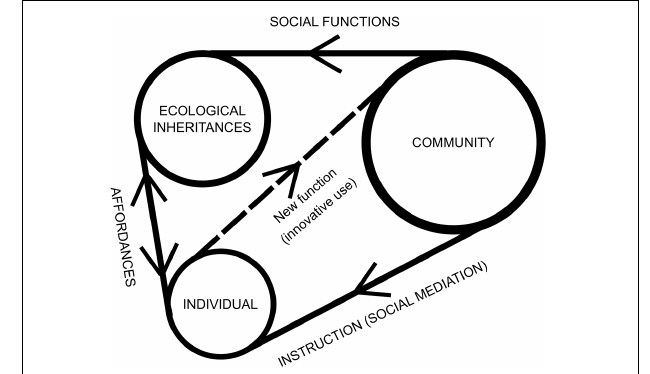
FIGURE 2 | Different interactions among an individual, her community and the ecological inheritances of her environment. Ecological inheritances are bestowed by the community with social functions that are taught to individuals via instructions, and those instructions serve to deal with the affordances available to individuals. At the same time, an individual can engage with an innovative use of an affordance and transmit it to the community (dotted line). If accepted, a new function for ecological inheritances is